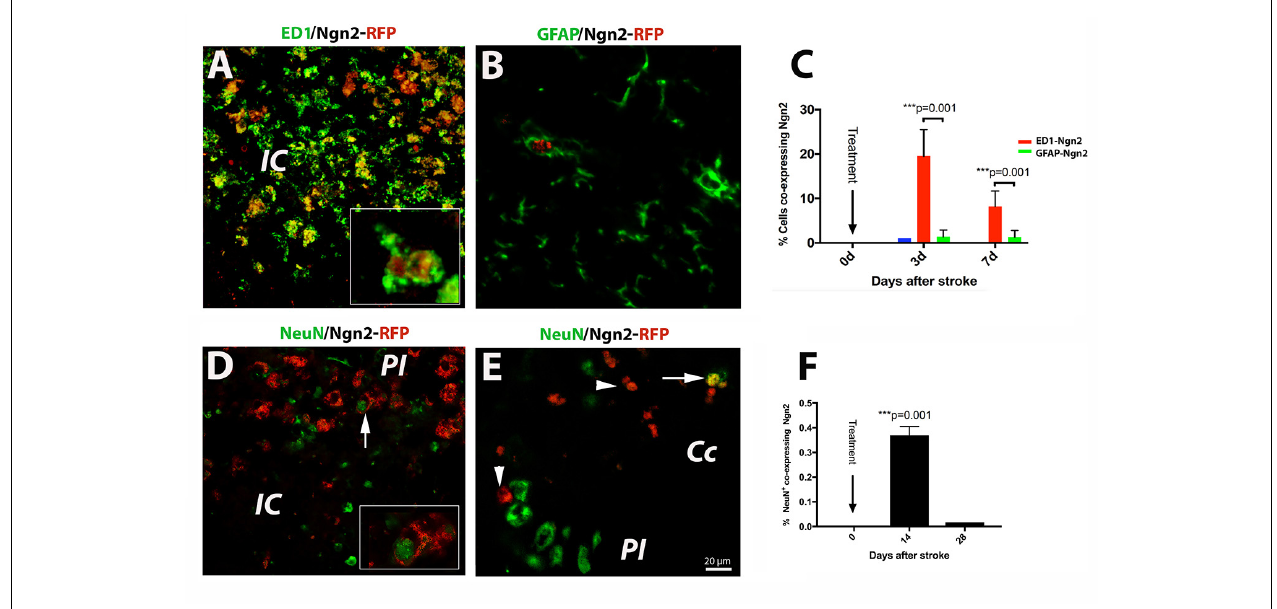
FIGURE 2 | ( Upper panel ) In situ reprogramming of proliferating ED1- and GFAP-positive cells by retroviral expression of Ngn2-RFP in the brains of young mice. By immunofluorescence, the large majority (19.4%, B ) of the Ngn2-RFP+ cells were macrophages cells at day 3 after stroke ( A ; and inset). Thereafter, by day 7 post-stroke, the number of cells co-expressing ED1 and Ngn2-RFP+ dropped to 8% (C) . Only a very small fraction of cells (less than 1%) co-expressed the astrocytic marker GFAP and Ngn2-RFP in the peri-infarcted area (B) . ( Lower panel ) Phenotyping and quantification of transduced cells in young mice. The conversion efficiency into neurons in the infarcted area of young mice was very low, about 0.35% ( D and inset; F ). In corpus callosum, we found, on rare occasions, double-labeled cells which were, based on morphology and localization in the corpus callosum, most likely, of hematogenous origin ( E , arrow). Scale bar, 20 µ m. N = 4 mice/group. ∗∗∗ P < 0.001, by one-way ANOVA with Tukey’s post hoc test for multiple group